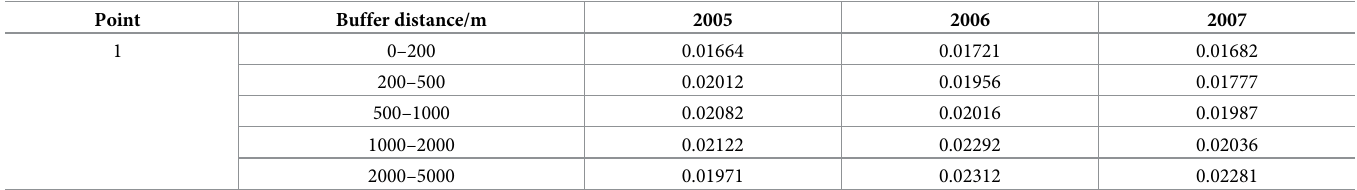
Table 4. Annual average VSWI within the radius of each interchange node of Yongjin Expressway before and after its construction(Show only part, S2 Table for complete table). Point